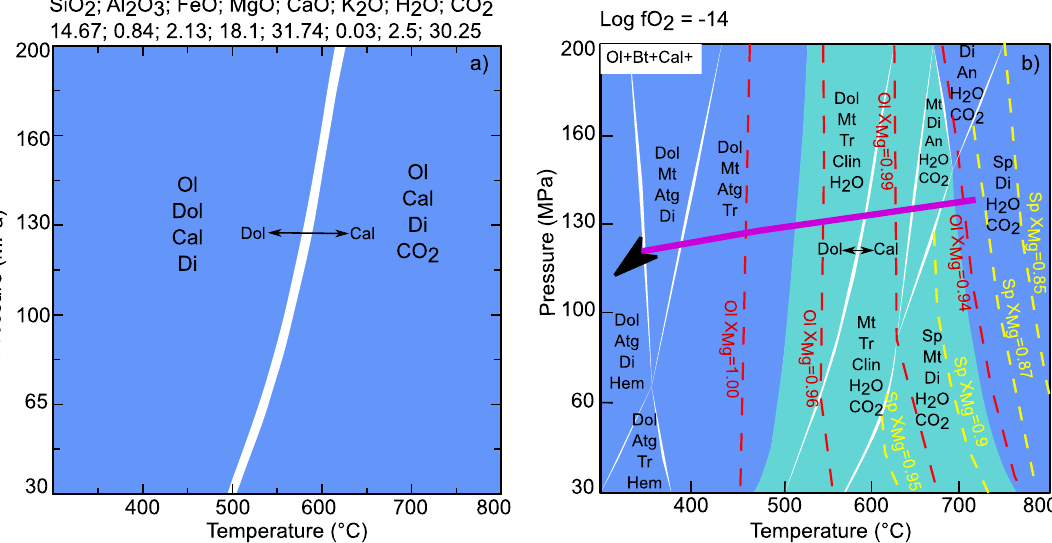
Figure 9. Pseudosection calculations showing stable minerals at different conditions. Bulk chemistry used for the calculation is given above the diagram. ( a ) The results with varying pressure and temperature from ( a ) 30 to 200 MPa and 300 to 800 °C and ( b ) 30 to 200 MPa and 300 to 800 °C at logfO 2 = −14. Pink arrow representing the possible evolutionary path followed by the metasomatized marble zone. OI—Olivine; Dol—Dolomite; Cal—Calcite; Di—Diopside; Mt—Magnetite; Hem—Hematite; Atg—Antigorite; Tr—Tremolite; Clin—Chlorite; Sp—Spinel; An—Anorthite . Because of the hematite that is present as oxidation rims on the serpentine pods, vein-filled